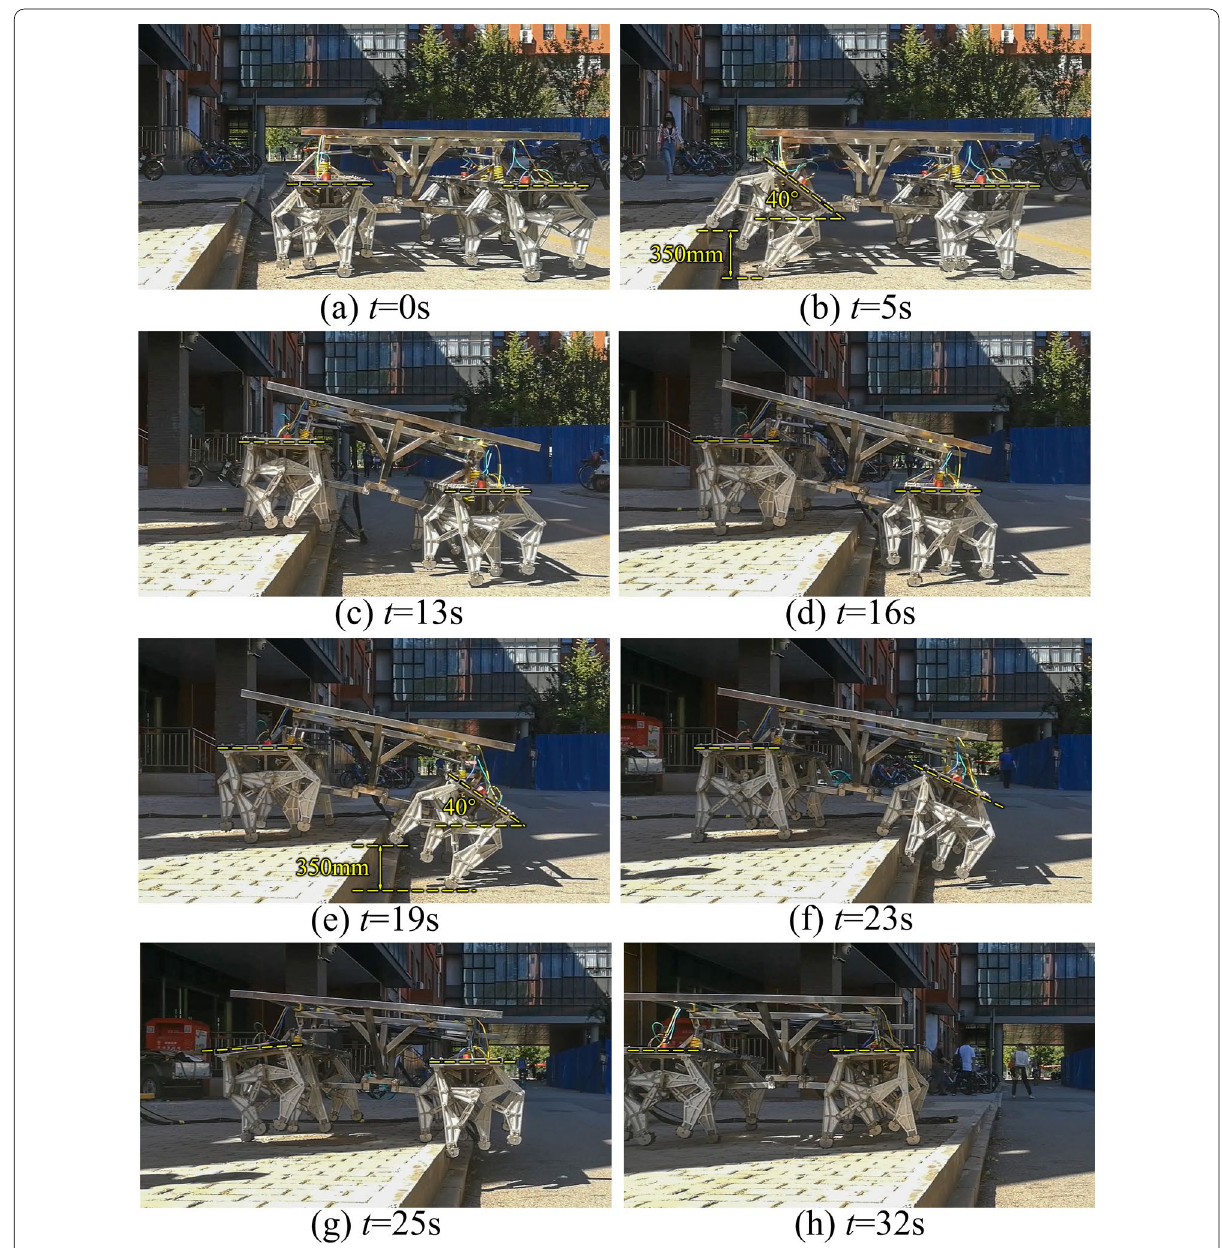
Figure 18 Experiment on 350 mm vertical